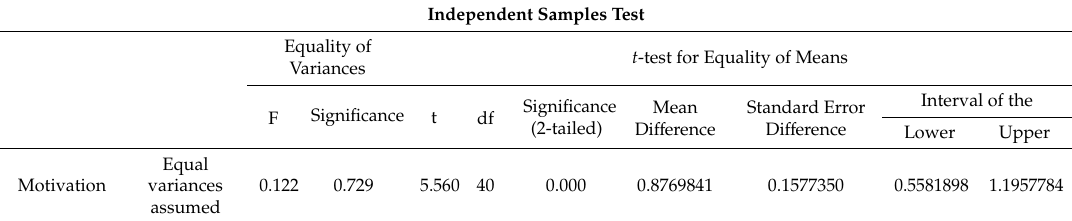
Table 2. Student motivation—independent samples t -test